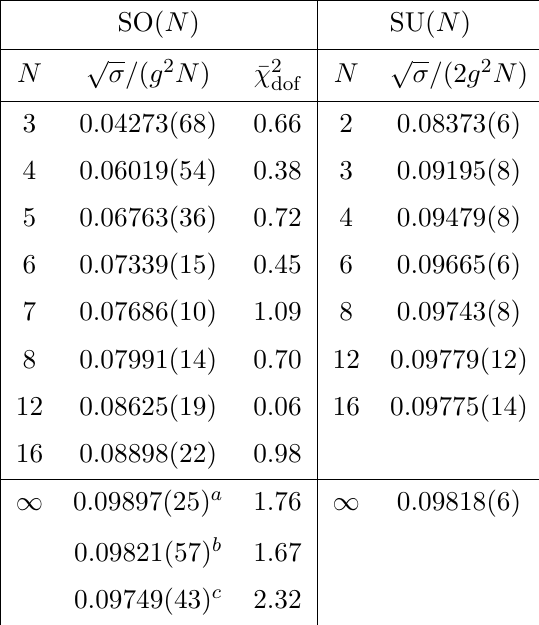
p Table 19 . SO( N ) continuum string tensions, (cid:27) , in units of the ’t Hooft coupling, g 2 N , and the (cid:31) 2 per degree of freedom of each continuum extrapolation. (Labels a , b , c denote di(cid:11)erent extrapolations: O (1 =N ) extrapolation for N (cid:21) 4, O (1 =N 2 ) extrapolation for N (cid:21) 4, O (1 =N ) extrapolation for N (cid:21) 3 respectively.) Also shown are SU( N ) values from [16], in units of 2 g 2 N . p some SU( N ) values of (cid:27)= 2 g 2 N taken from [16]. The extra factor of 2 encodes the fact that in identifying the planar limits of SO( N ) and SU( N ) one equates g 2 N in the former with 2 g 2 N in the latter [1]. We plot these SU( N ) values in (cid:12)gure 22. Since the leading large- N correction in SU( N ) is O (1 =N 2 ), the points near N = 1 will fall on a quadratic curve. To get a good (cid:12)t one needs to include a subleading correction, giving for our best (cid:12)t p